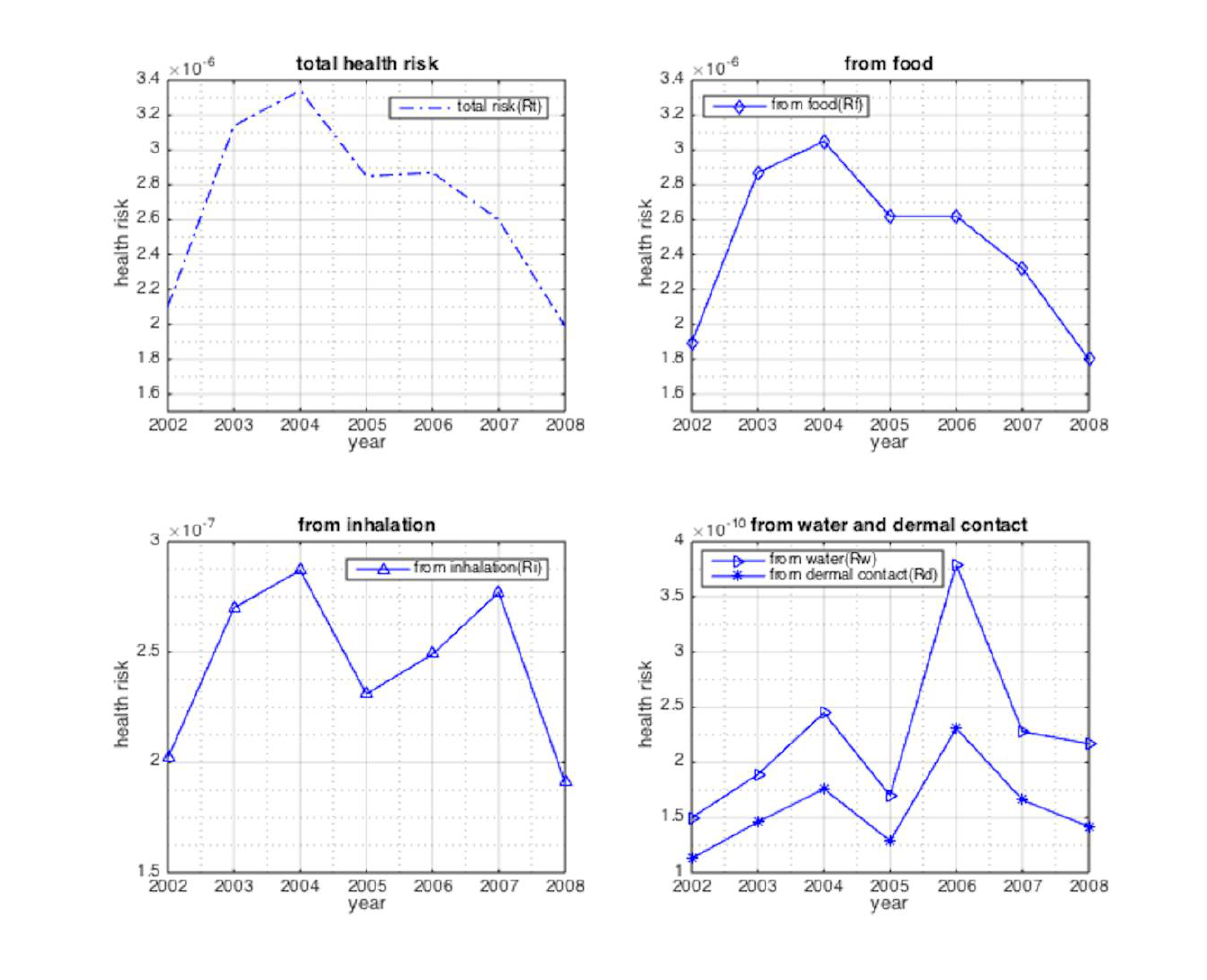
Figure 3. The annual average cancer risk from different pathways from 2002 to